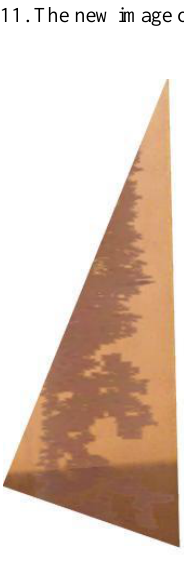
Figure 12. The upper-right triangle of new image of test 3